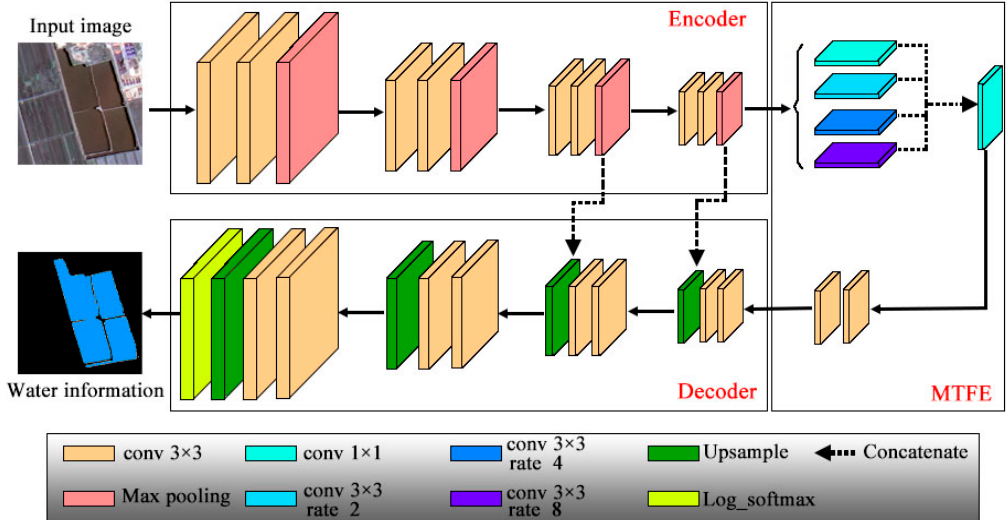
Figure 5. The structure of the multi-scale water extraction convolutional neural network (MWEN).